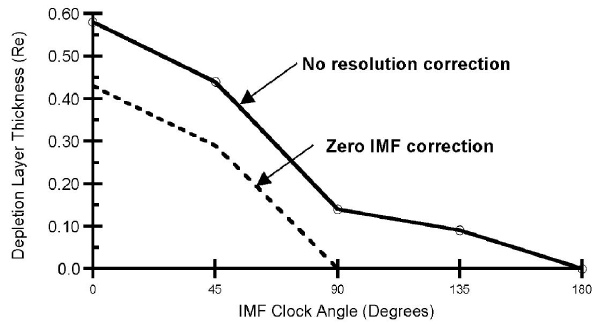
Fig. 12. Taken from Siscoe et al. (2002). Dependence of the thick- ness of the depletion layer, as defined by Zwan and Wolf (1976), obtained from Fig. 11 on the IMF clock angle. A value of 0.15 R E , representing the resolution of the process, has been subtracted from the solid line to obtain the dashed